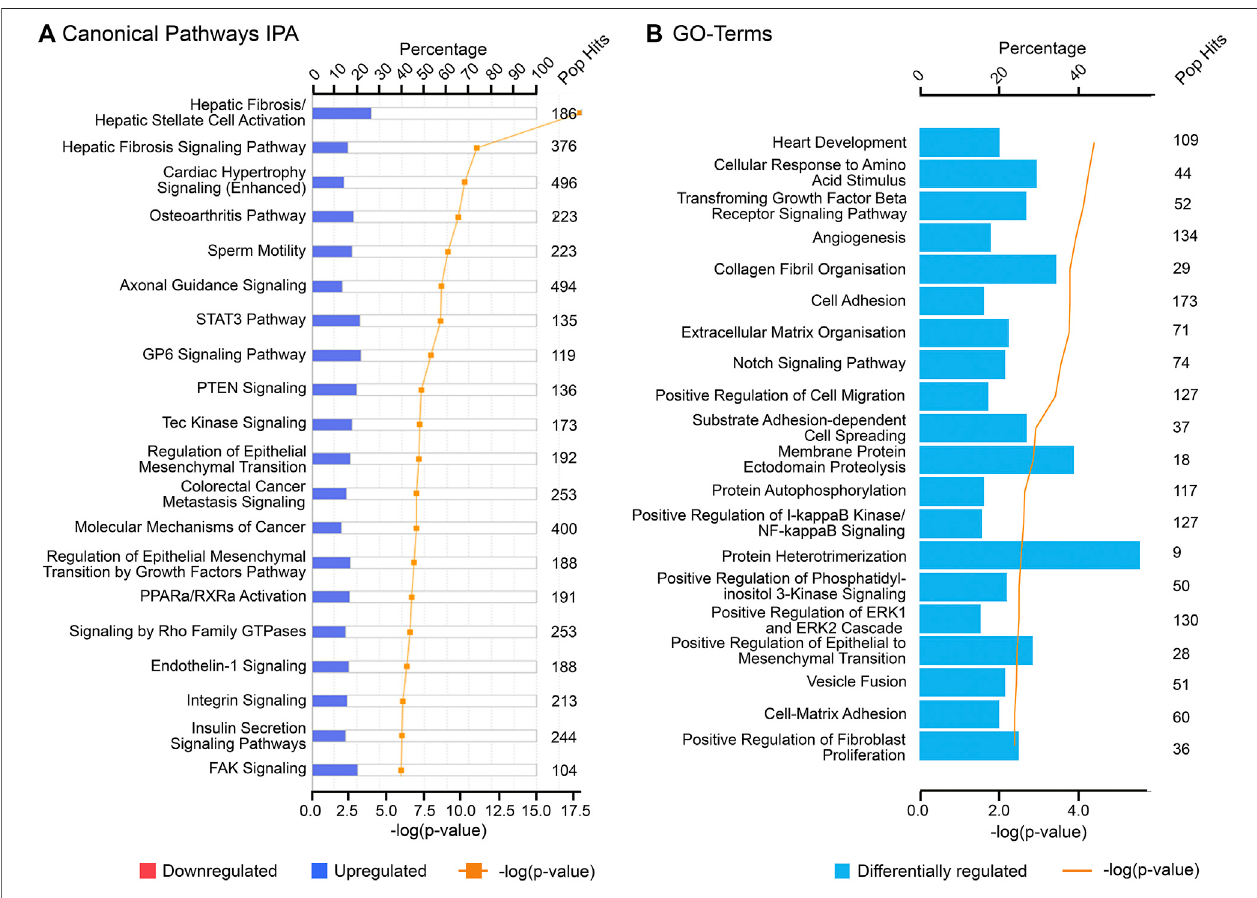
FIGURE 4 | Top canonical pathways associated with cluster 2 ( “ late ” genes) using (A) Ingenuity Pathway Analysis (IPA) and (B) Gene Ontology (GO), biological processes from DAVID database. “ Pop Hits ” refers to the total number of genes associated with each of the pathway in the database. The bar graphs represent the percentageofgenesfromthedatasetthatmaptoeachcanonicalpathwaywhilsttheorangelineshowsthe p -valueofoverlapbetweengenesineachclusterandagiven pathway.